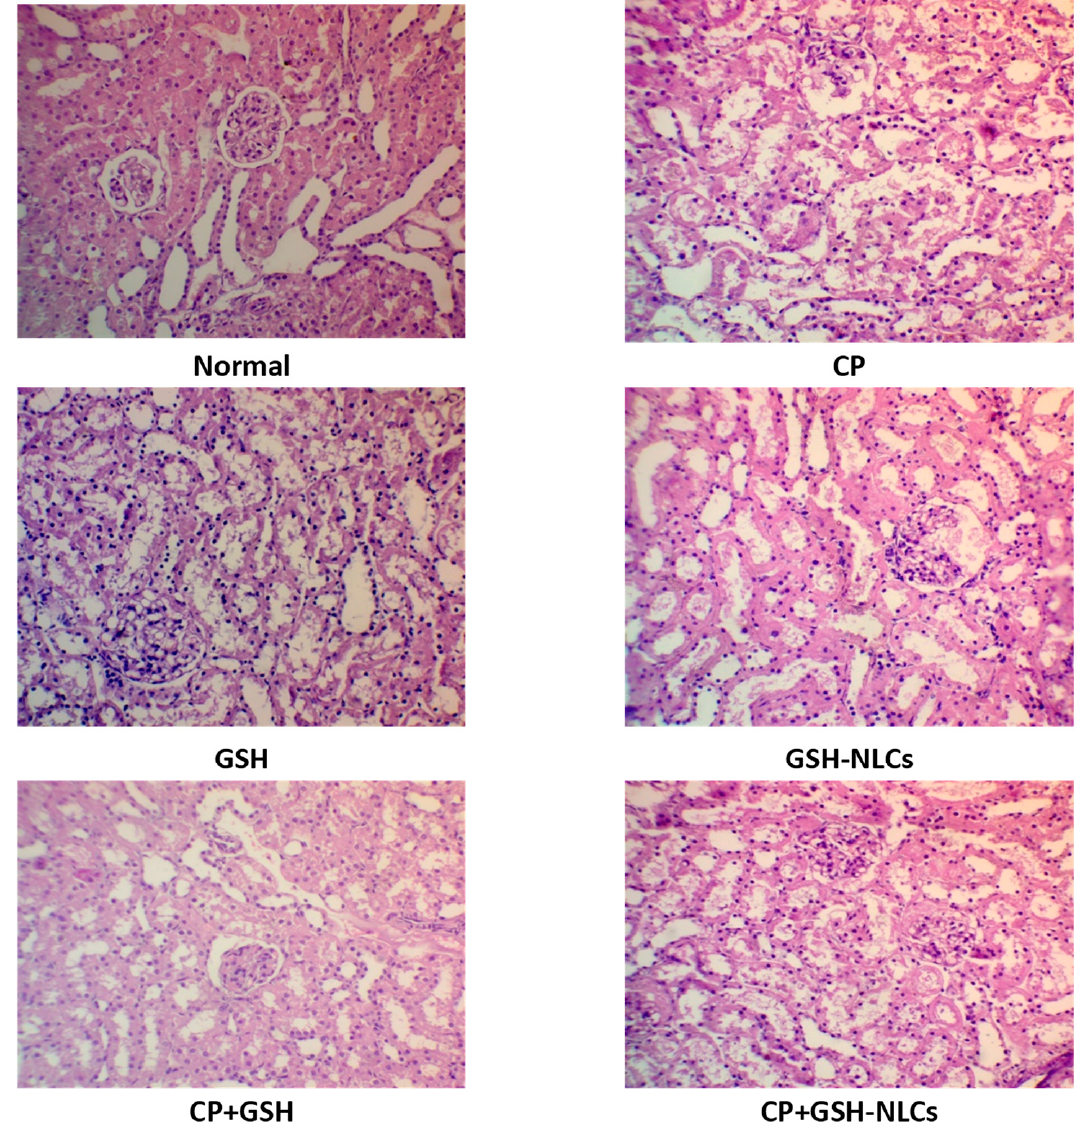
Figure 5. Histopathology of rats’ kidney (H & E stain, magnification × 200) of Normal = Normal rats; CP = Cyclophosphamide-injured rats; GSH = glutathione-treated rats, GSH-NLCs = nano-glutathione-treated rats; CP+GSH = Cyclophosphamide + Glutathione-treated rats; CP+GSH-NLCs = Cyclophosphamide + nano-glutathione-treated rats .